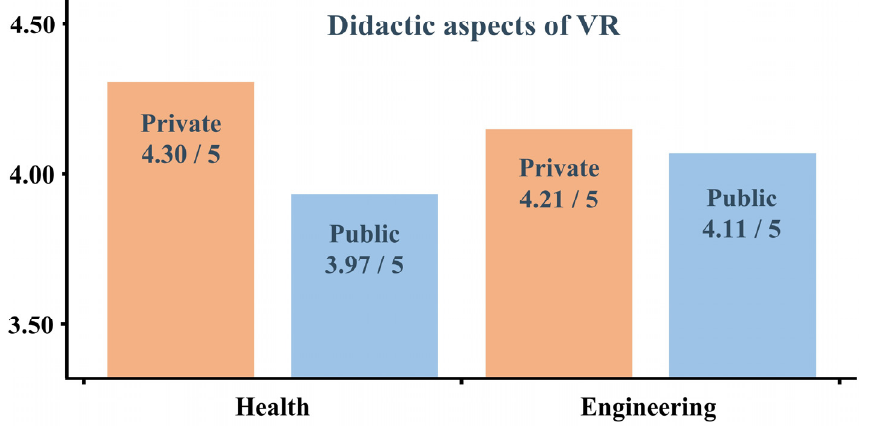
Figure 5. Didactic aspects of VR (rating out of 5).